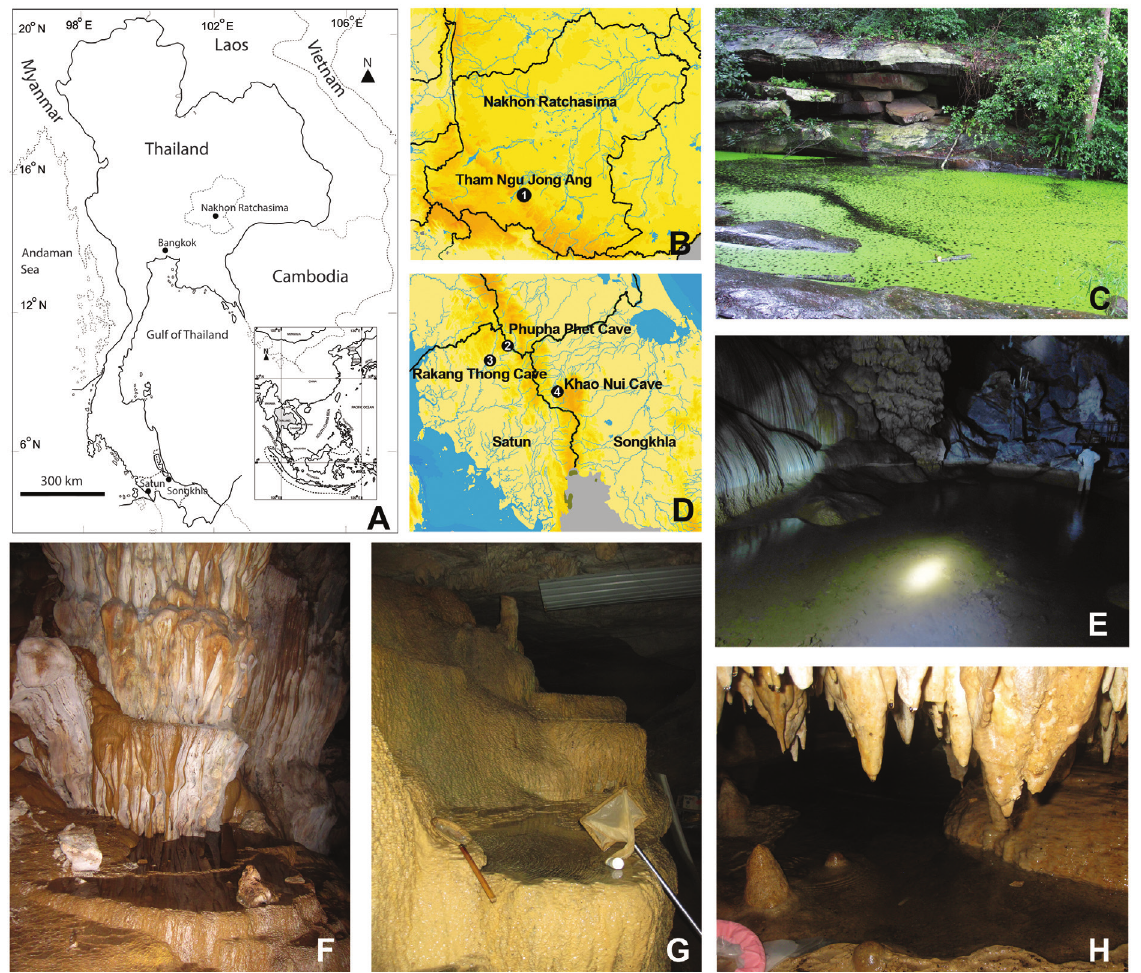
Fig. 1. Geographical location and details of the sampling sites. A . Map of Thailand and a location of Nakhon Ratchasima, Satun and Songkhla Provinces. B–C . Location (indicated by a black circle with no. 1) and sampling point of headwater stream in Nakhon Ratchasima Province. D . Locations of caves in Satun and Songkhla Provinces (indicated by black circles with nos 2, 3, 4). E–F . Sampling points in Phupha Phet Cave. G–H . Sampling points in Rakhang Thong Cave and Khao Nui Cave,